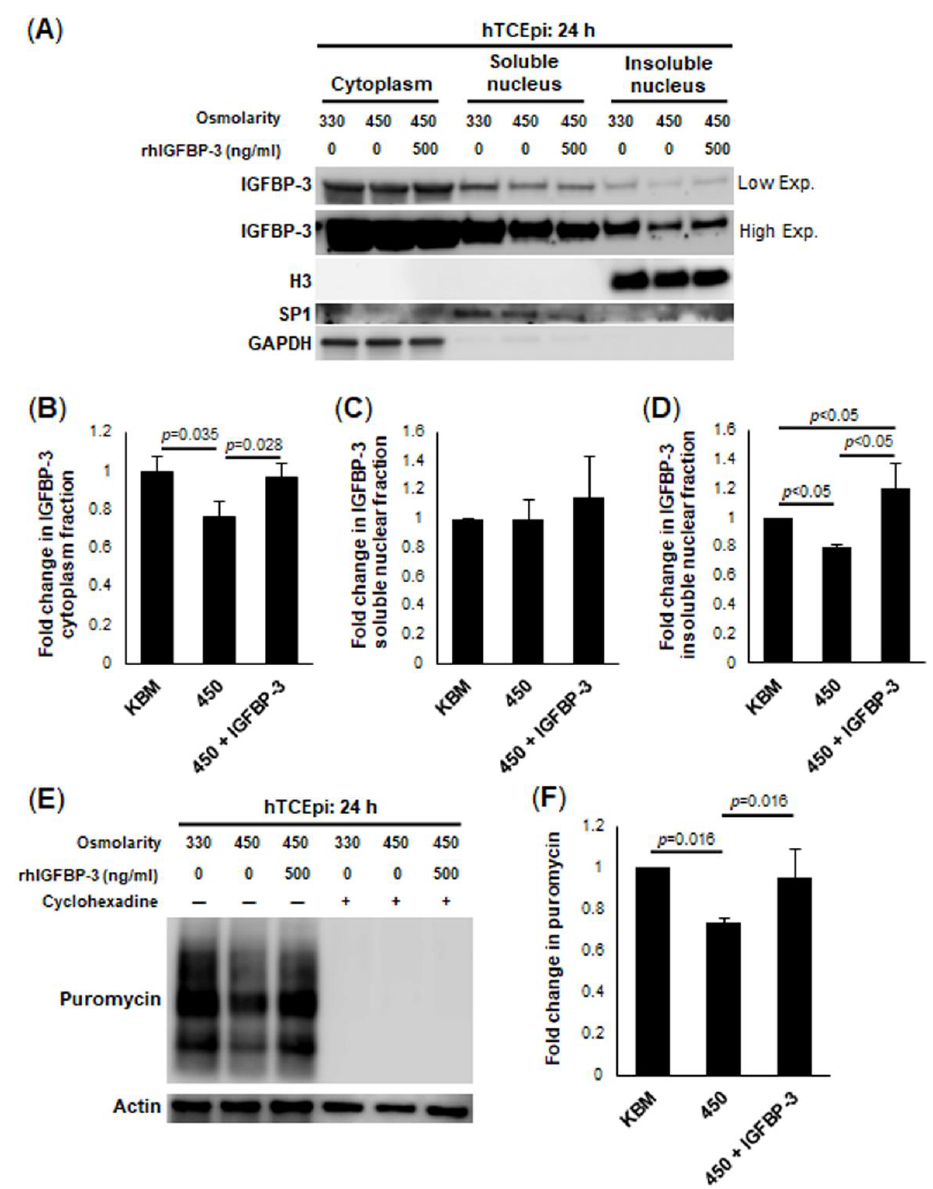
Figure 4. Treatment with exogenous IGFBP-3 drives IGFBP-3 accumulation in the insoluble nucleus during hyperosmolar stress. hTCEpi cells were treated with isotonic or 450 mOsm KBM for 24 h. Additional cells in 450 mOsm KBM were co-treated with 500 ng/mL rhIGFBP-3. ( A ) Cell lysates were separated into cytoplasmic, soluble nuclear and insoluble nuclear fractions. GAPDH was used as a loading control for the cytosolic fraction, SP1, for the soluble nuclear fraction, and H3 for the insoluble nuclear fraction. There was a decrease in IGFBP-3 in 450 mOsm without rhIGFBP-3 in the cytoplasm and insoluble nuclear fraction compared to control. Co-treatment with rhIGFBP-3 blocked the hyperosmolar-mediated decrease. Low exposure of the membrane was used to visualize IGFBP-3 in the cytoplasm and high exposure was used to visualize IGFBP-3 in the insoluble nucleus. ( B ) Quantitative data for IGFBP-3 in the cytoplasm, ( C ) soluble nucleus, and ( D ) insoluble nucleus. ( E ) A SUnSET puromycin assay was used to examine global protein translation. β -actin was used as a loading control. Similar to the findings above, there was a decrease in protein translation in cells cultured in 450 mOsm KBM that was not evident in cells co-treated with rhIGFBP-3. Cyclohexadine was used to confirm that only newly translated protein was observed. ( F ) Quantification of puromycin bands from Western blot. Data are presented as mean ± standard deviation from 3 representative experiments and analyzed using a one-way ANOVA and SNK multiple comparison